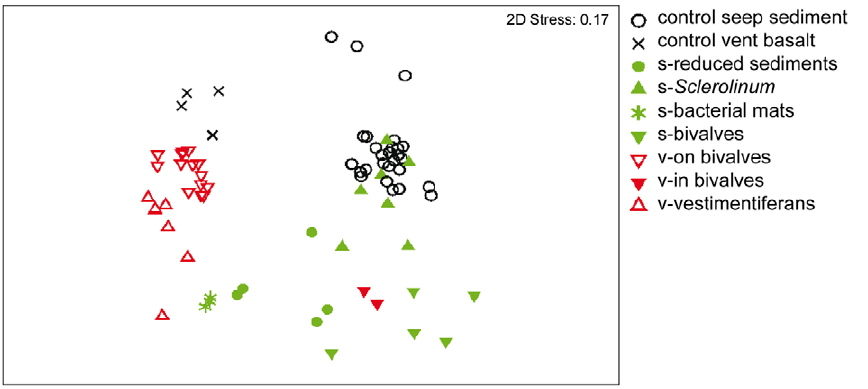
Figure 3. 2-dimensional MDS configuration plot for 20 samples from deep-sea cold seeps (all in green colour), 22 samples from hydrothermal vents (all in red colour), and 27 samples from control samples (all in black). In addition to division into ecosystems by colour code, habitats of ecosystem are discriminated by different signs into (1) control seep sediment, (2) control vent basalt (both Control), (3) s- reduced sediments, (4) s-Siboglinid, (5) s-bacterial mats, (6) s-bivalves (s=seep; 3–6 all infauna), (7) v-on bivalves (v=vent, epifauna), (8) v-in bivalves (v=vent, infauna), and (9) vestimentiferans (v=vent, epifauna).